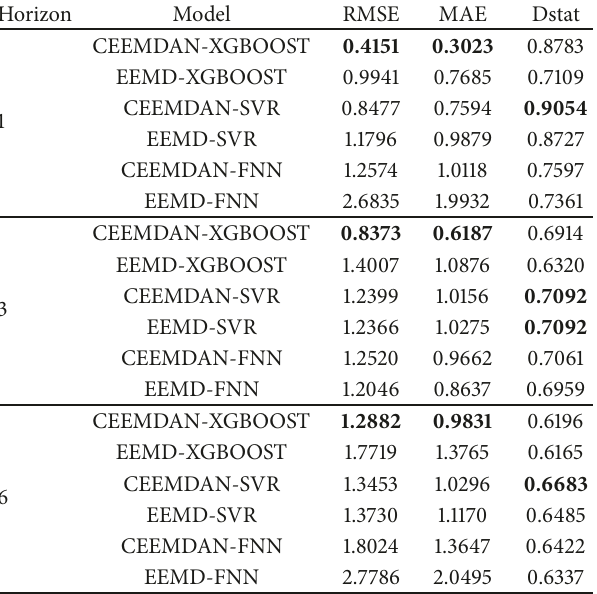
Table 5: The RMSE, MAE, and Dstat by the models with EEMD or CEEMDAN.